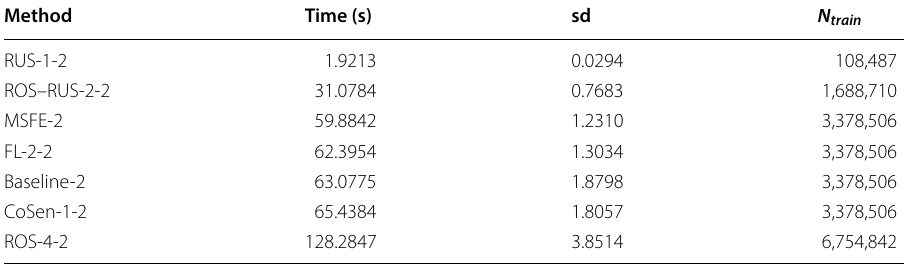
Table 21 Average training time per epoch